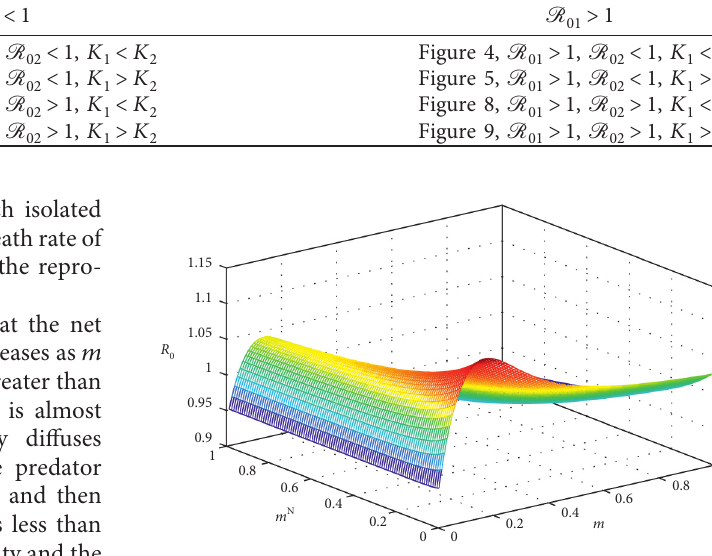
Figure 2: The effects of the diffusion rates on the net reproduction � 0 . 96, R � 0 . 9257, K � 2 . 8, K � 3, where R number R 0 01 02 1 2 d N � 0 . 18, d N � 0 . 23, and m N , m J � m A � m vary from 0.01 to 1; 1 2 all other parameters are given in equation (71).